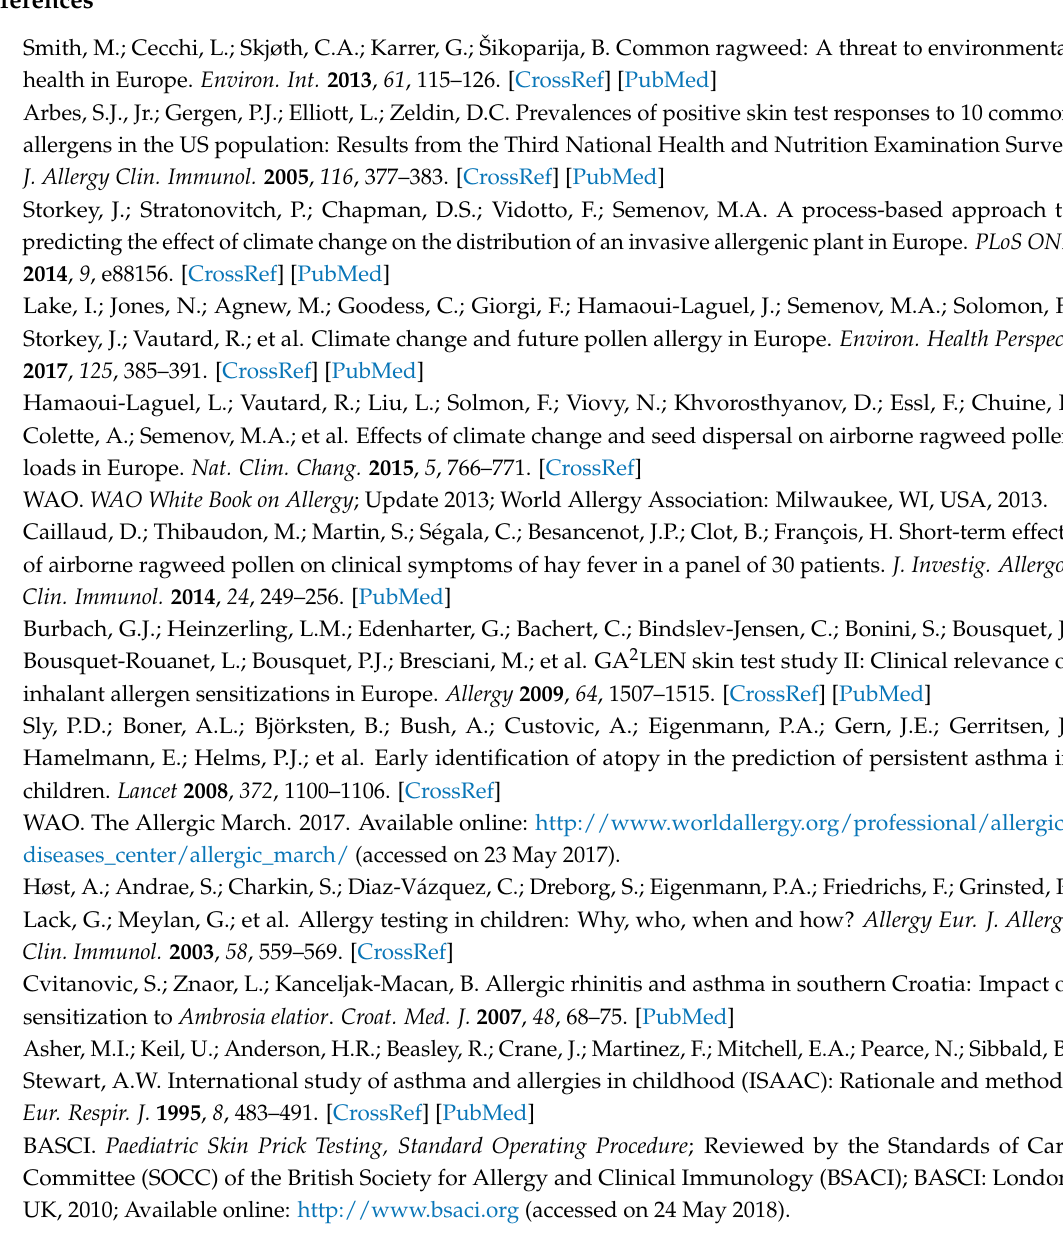
s1. Table S1. A full list of explanatory